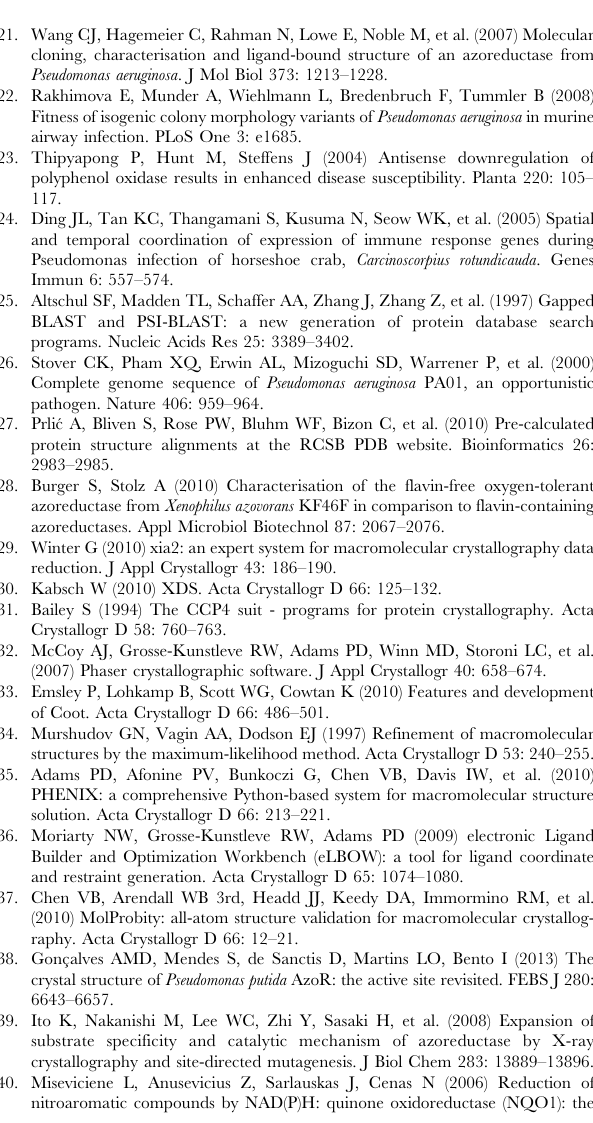
Figure S1 Flowchart outlining the bioinformatics pro- cedure applied to identifying members of the azoreduc- tase family. Figure S2 Azo compound substrate specificity profiles of paAzoR1 (A), paAzoR2 (B) and paAzoR3 (C). Abbrevi- ations for all substrates are as follows; balsa – balsalazide, pabsa - p-aminoazobenzene-4 9 -sulfonate, sulfa – sulfasalazine, olsa – olsalazine, metred – methyl red, tropa- tropaeolin O, amar – amaranth, ponc S/BS – ponceau S/BS,. All rates are normalised relative to the maximum rate of reduction of Balsalazide